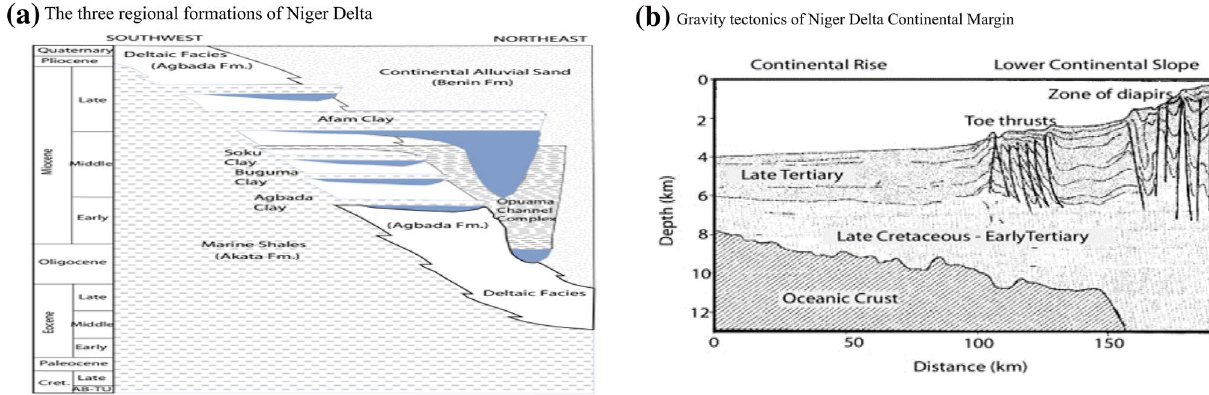
Fig. 3 The Niger delta formations and gravity tectonics (Tuttle et al.